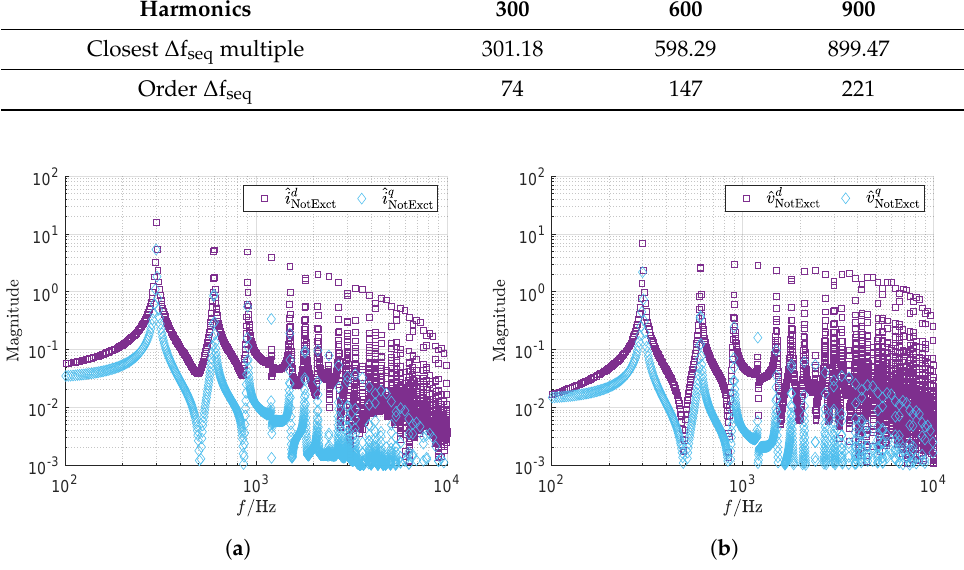
Figure 10. Base scenario in with the harmonics of the grid are measured. ( a ) Spectrum of the current i harm in the dq domain. ( b ) Spectrum of the voltage v meas in the dq